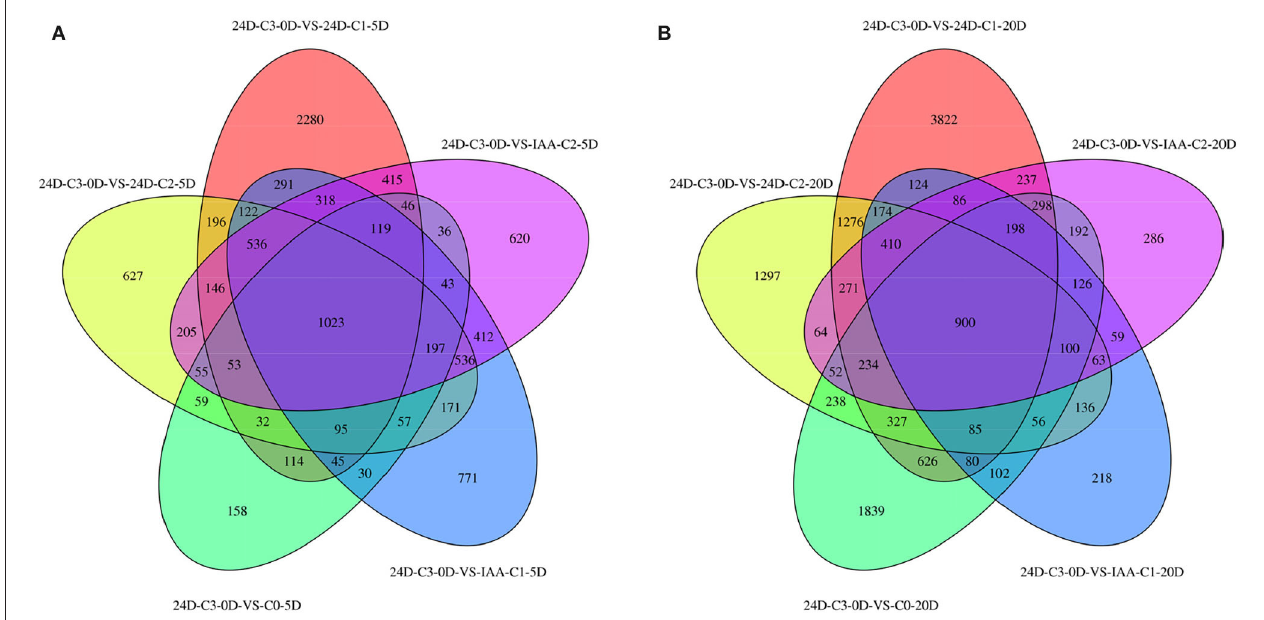
FIGURE 2 | Venn diagram of DEGs between different comparison groups. (A) C3 was compared with 0.025mg L − 1 of IAA at 5 days. (B) C3 was compared with different concentrations of 2,4-D. IAA, indole acetic acid; 24D, 2,4-dichlorophenoxyacetic acid; C0, 0mg L − 1 ; C1, 0.025mg L − 1 ; C2, 0.05mg L − 1 ; C3, 0.1mg L − 1 ; 5D, 5 days’ treatment; 20D, 20 days’